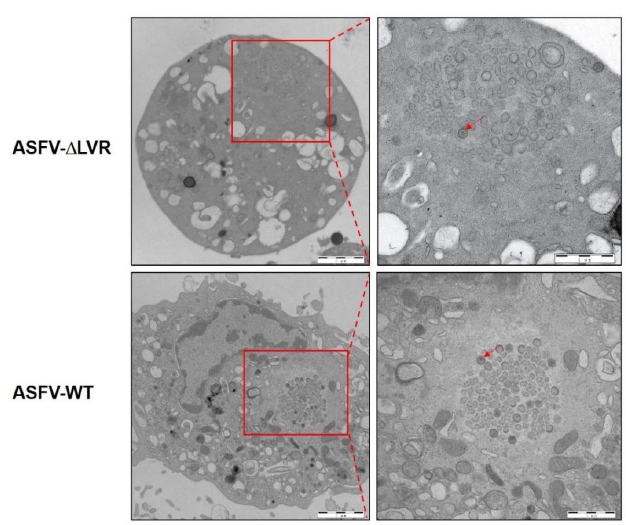
Figure 3. Morphology of virus factories in the ASFV-infected PAMs. PAMs were infected with ASFV-WT or ASFV- ∆LVR (MOI = 5) and fixed with 2% glutaraldehyde at 24 hpi. The fixed cells were analyzed by transmission electron microscopy.